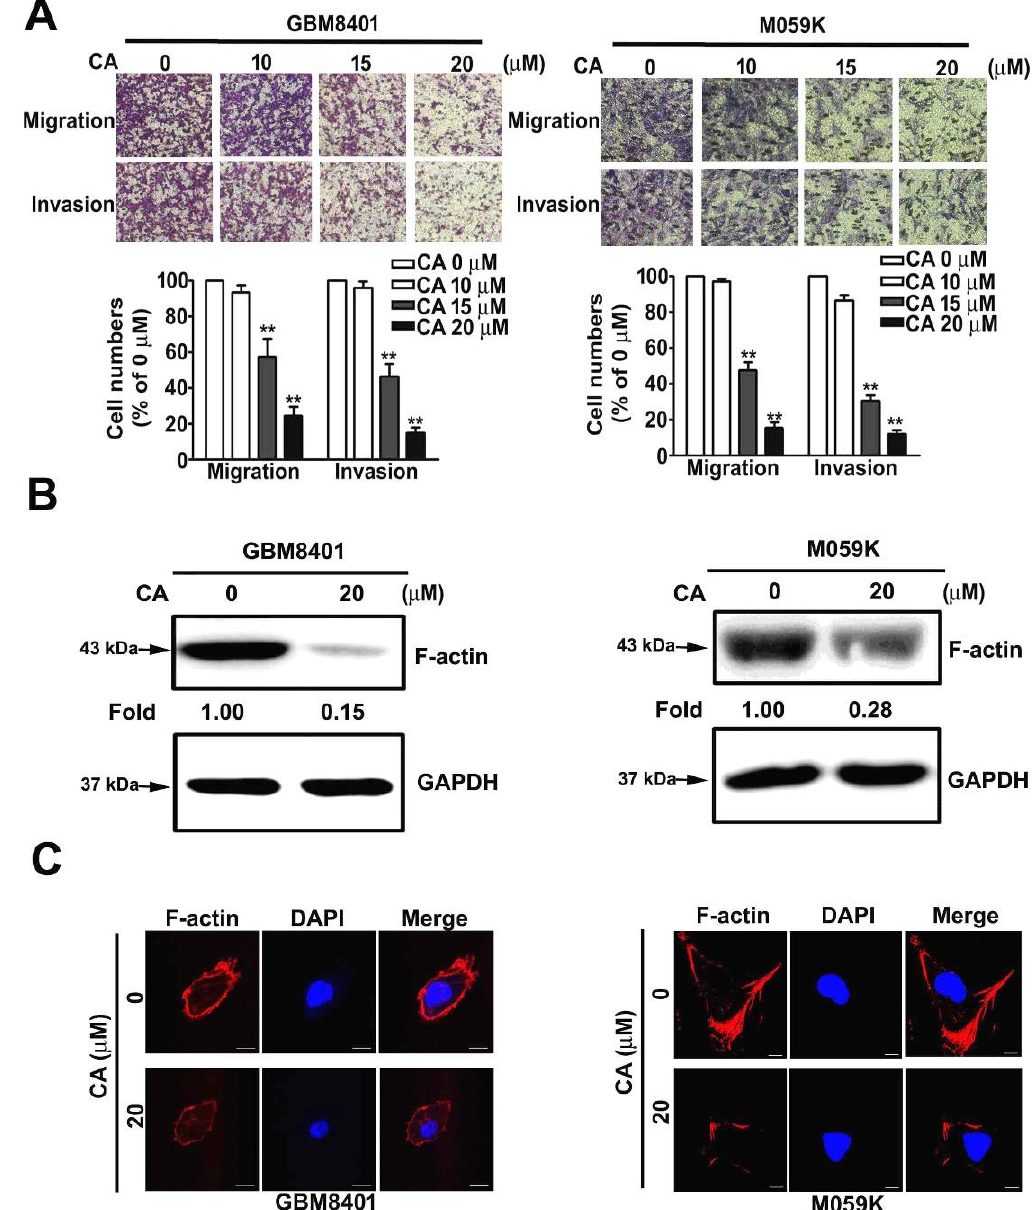
Figure 3. CA attenuated the migration and invasion of GBM cells and reduced expression and organization of cytoskeletal F-actin in GBM cells. ( A ) GBM8401 and M059K cells were treated with CA at indicated concentrations, and then cell migration and invasion were assessed and quantitated as a percentage of the control. ** p < 0.01 compared with the control. ( B ) GBM8401 and M059K cells were treated with CA (20 µ M) and then lysed for immunodetection of F-actin by Western blotting. GAPDH was used as an internal control. ( C ) GBM8401 and M059K cells were treated with CA (20 µ M) and then stained with phalloidin for F-actin (red) and DAPI for the nucleus (blue). Images were acquired using a confocal microscope at 200 × magnification. ** p < 0.01 compared with the control (DMSO-treated cells). Scale bar = 50 µ m.